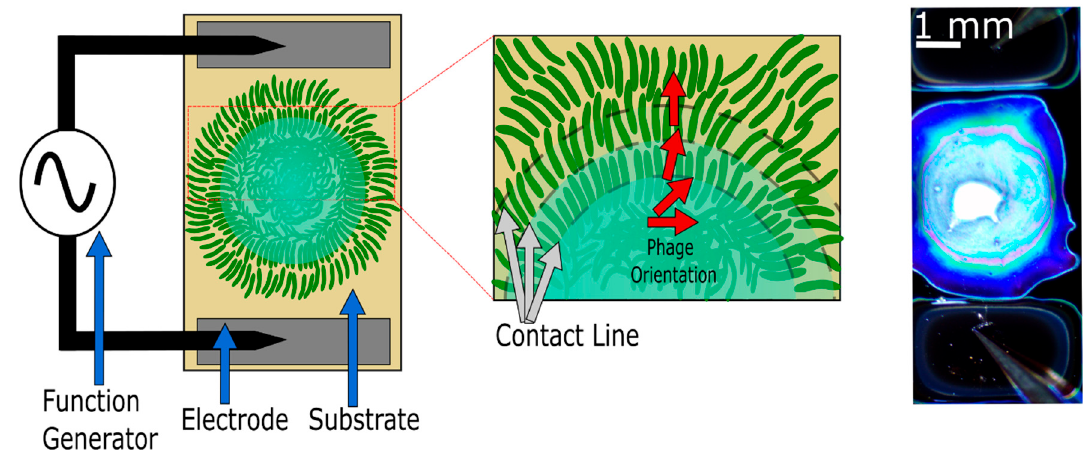
Figure 2. Schematic of the experimental setup. The applied field causes charges to redistribute along the three-phase contact line, modifying the interfacial- and line-tension between phases, causing the contact line to become unpinned from the substrate and recede at a near-constant rate as the droplet evaporates. As the contact line recedes, the phage bundles become radially aligned. The red arrows demonstrate the orientation of aligning bacteriophages. The dashed line represents the contact line.